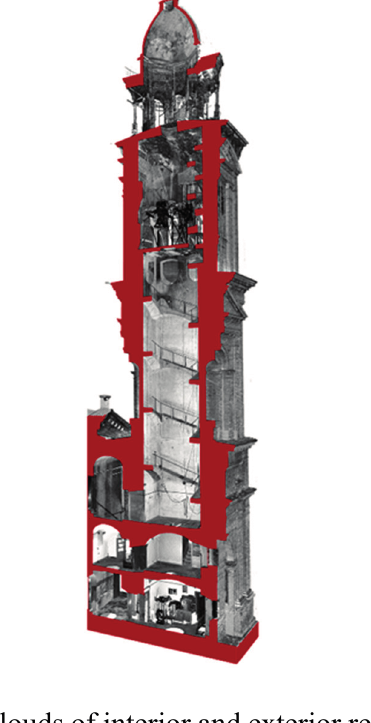
Figure 4. Laser scanner point clouds of interior and exterior registered in the local reference system for the elaboration of the